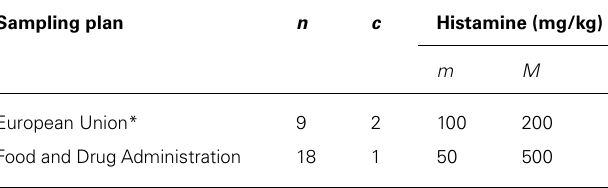
Table 1 | Sampling schemes for histamine content in fishery products. Sampling